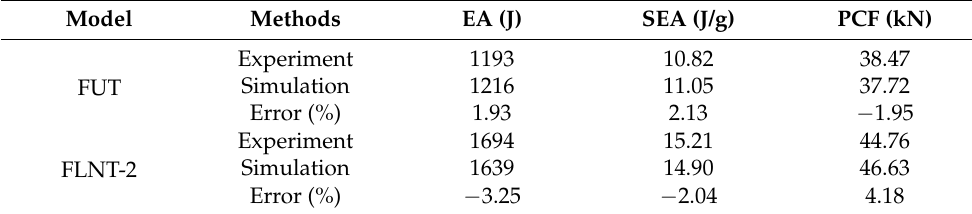
( b ) Figure 11. Mesh convergence study: ( a ) aluminum foam and ( b ) local nanocrystallized tube.